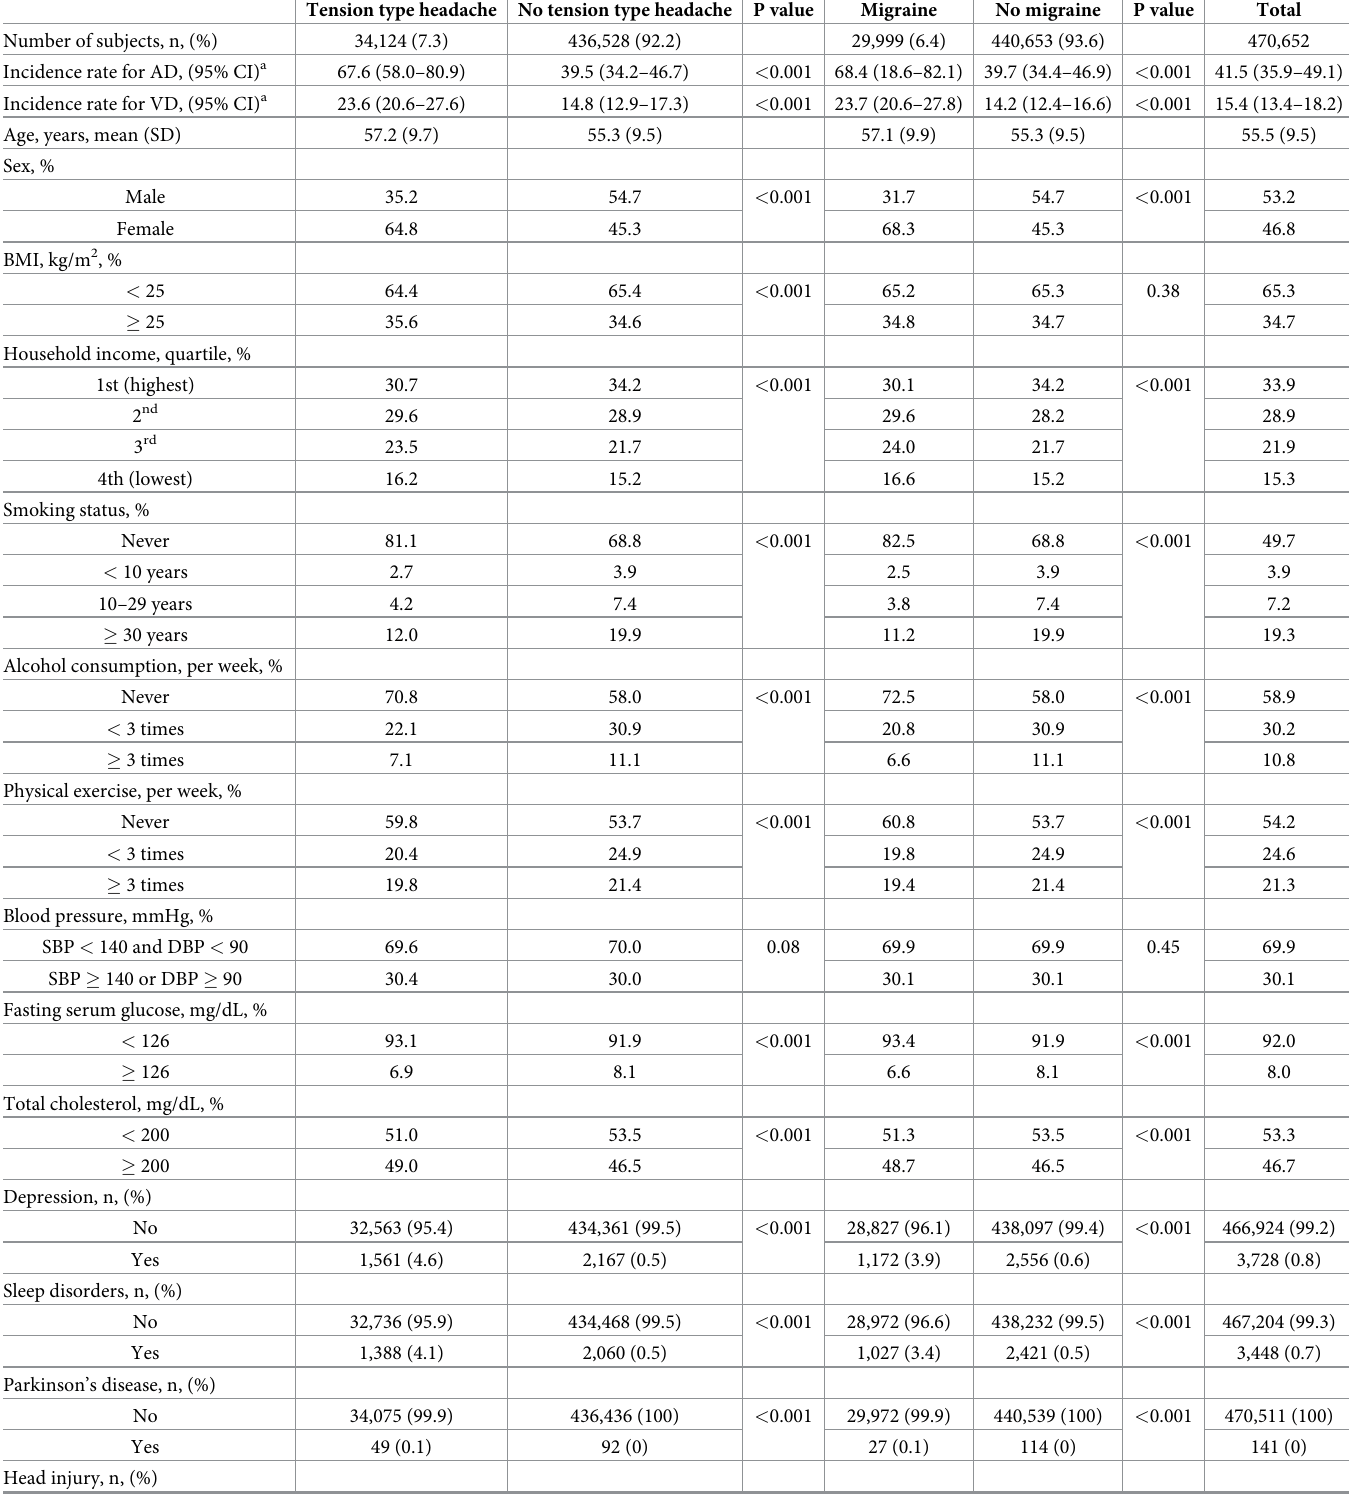
Table 1. Demographic and clinical characteristics of the study population according to headache